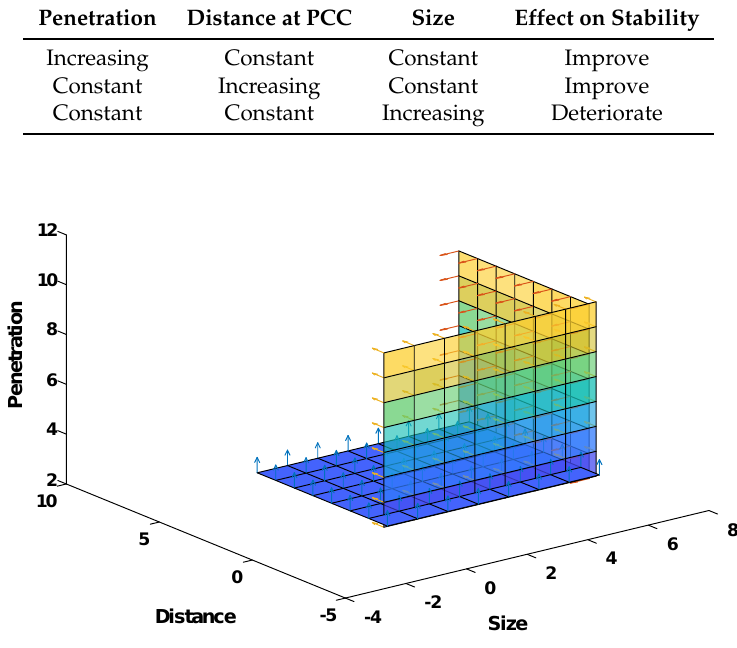
Figure 11. The stability behavior at the PCC for different sizes, distances, and